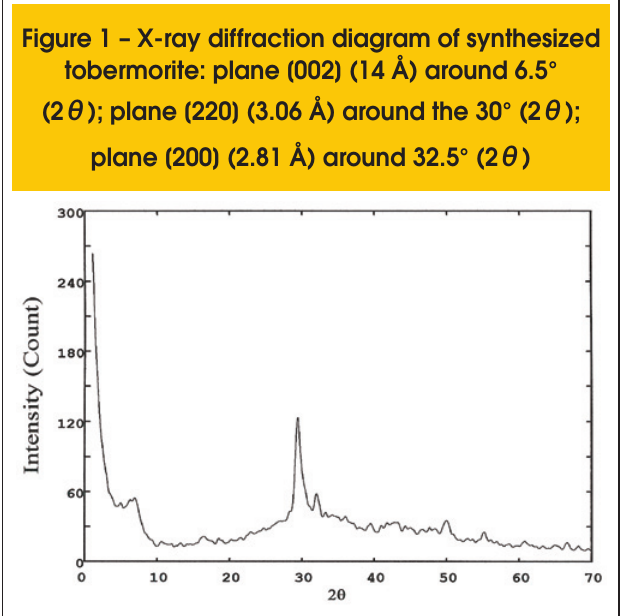
Figure 2 – X-ray diffractogram of C-S-H produced by pozzolanic synthesis with varying Ca/Si ratios, with and without poly